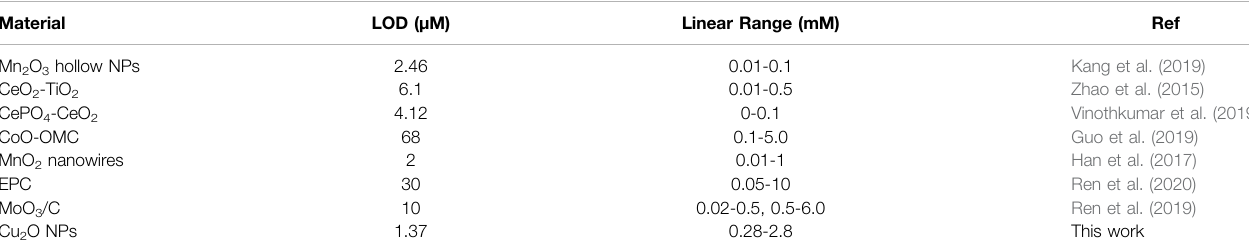
TABLE 1 | Comparison of linearity and LOD results for different materials-based glucose biosensors.